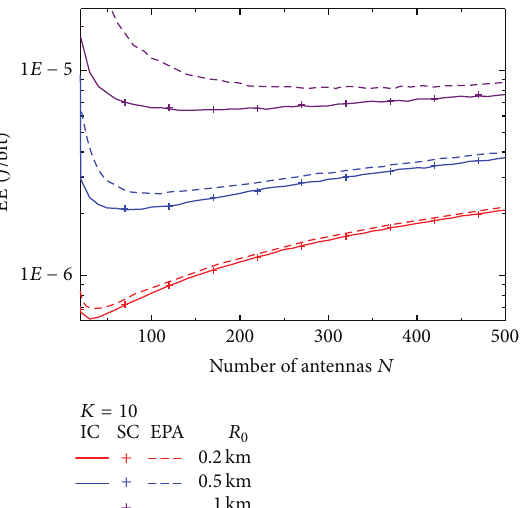
Figure 4: EE versus the number of node pairs 𝐾